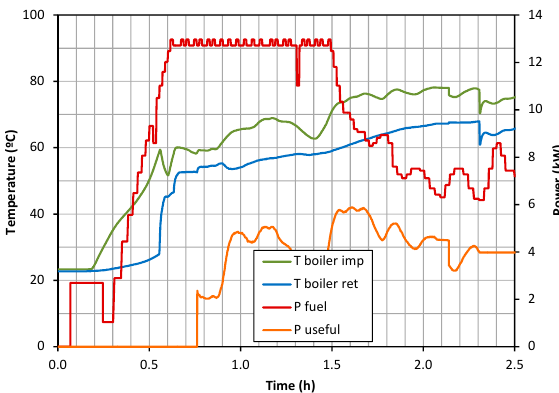
Figure 10. Temperature and power during the combustion test of LAB1.